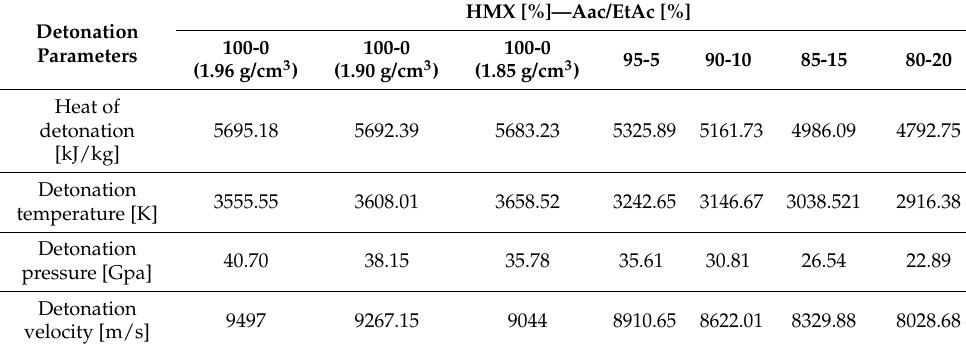
Table 8. Detonation parameters (JCZ